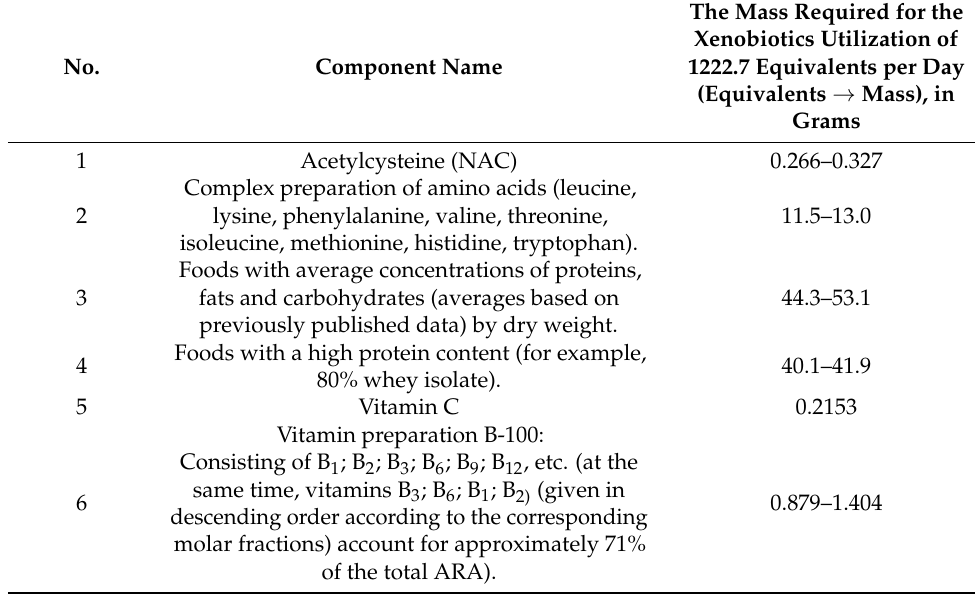
Table 5. Masses of main low-molecular-weight substances from food products necessary for the utilization of xenobiotics, without taking into account the possible ARA of other food